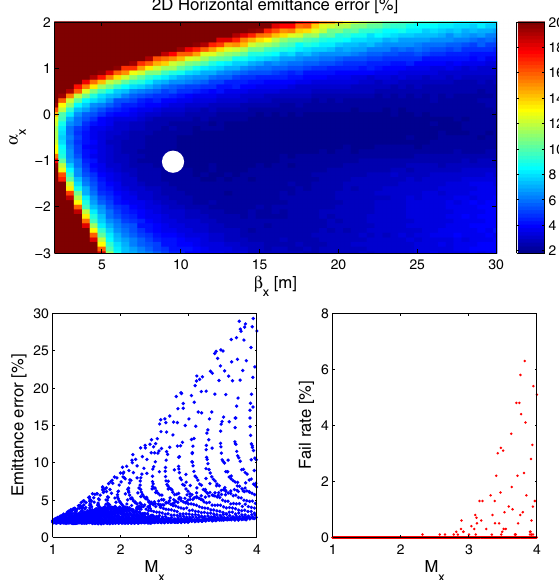
FIG. 6. The upper plot shows the relative horizontal 2D emittance error for different incoming optics. The color code is limited to 20% to make the details around the matched solution (white dot) visible. A relative beam size measurement error of 5% is assumed. The lower plots show the emittance error (left) and the failed fits (right) as a function of the mismatch parameter for the cases for which M ≤ 4 . For each point we performed simulations with 1000 different random seeds.